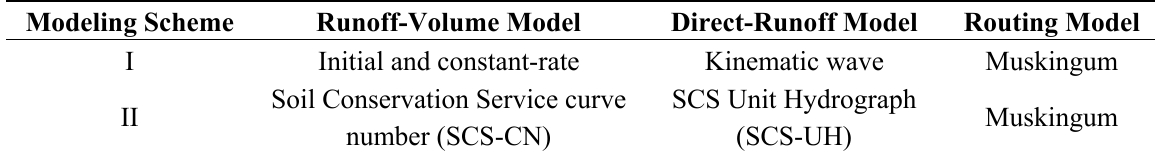
Table 3. Planned modeling